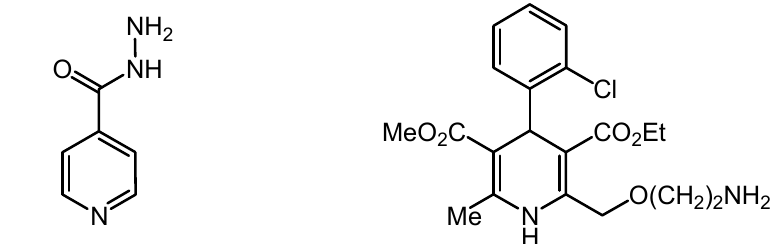
Figure 1 . Drugs containing the pyridine